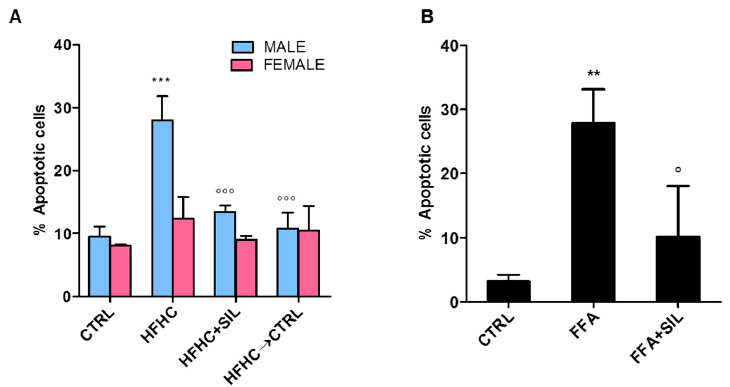
Figure 6. Effect of silymarin formulation on apoptosis. The number of cells undergoing apoptosis was counted in vivo ( A ) and in vitro ( B ). * p < 0.05 vs. CTRL; ** p < 0.01 vs. CTRL; *** p < 0.001 vs. CTRL; ◦ p < 0.05 vs. HFHC/FFA; ◦◦◦ p < 0.001 vs. HFHC/FFA.